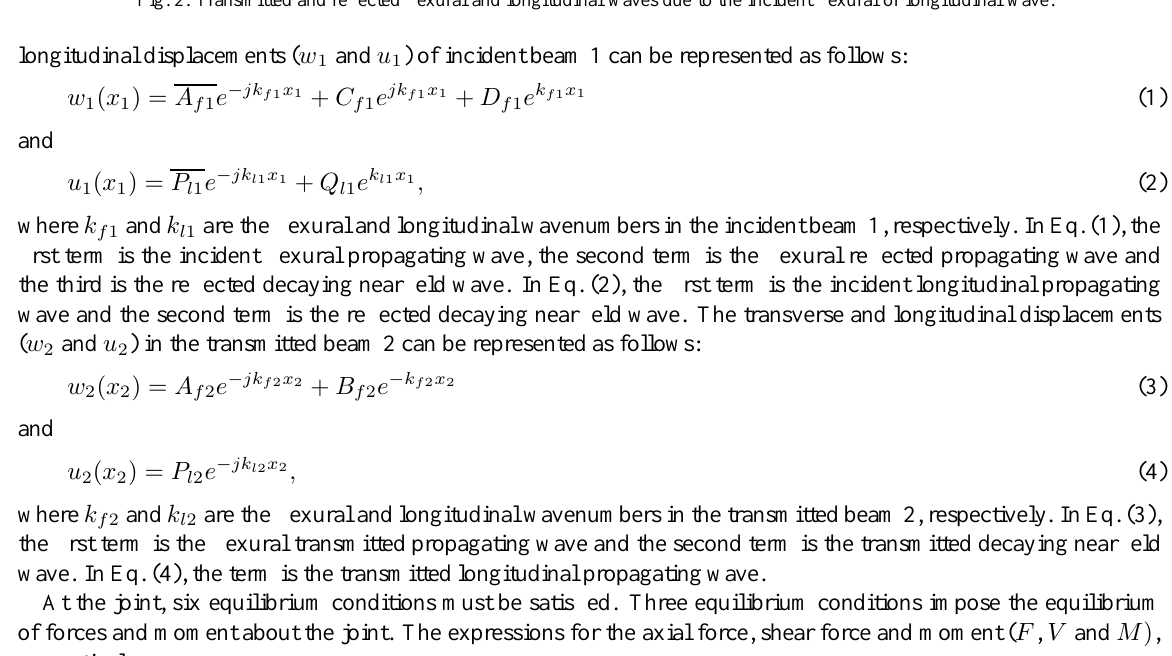
Fig. 2. Transmitted and reflected flexural and longitudinal waves due to the incident flexural or longitudinal